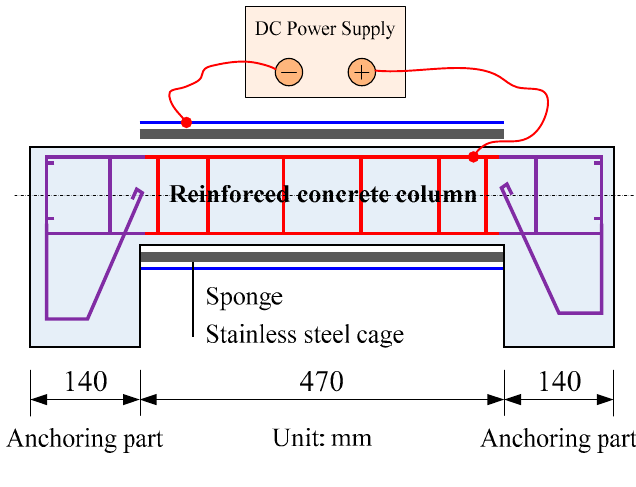
Figure 2. Corrosion setup.